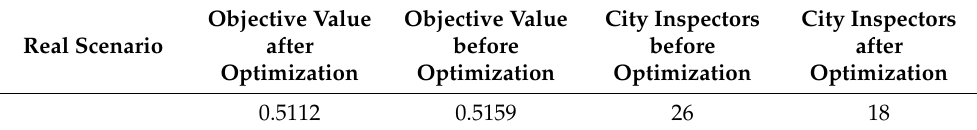
Table 7. Comparison of the solution before and after